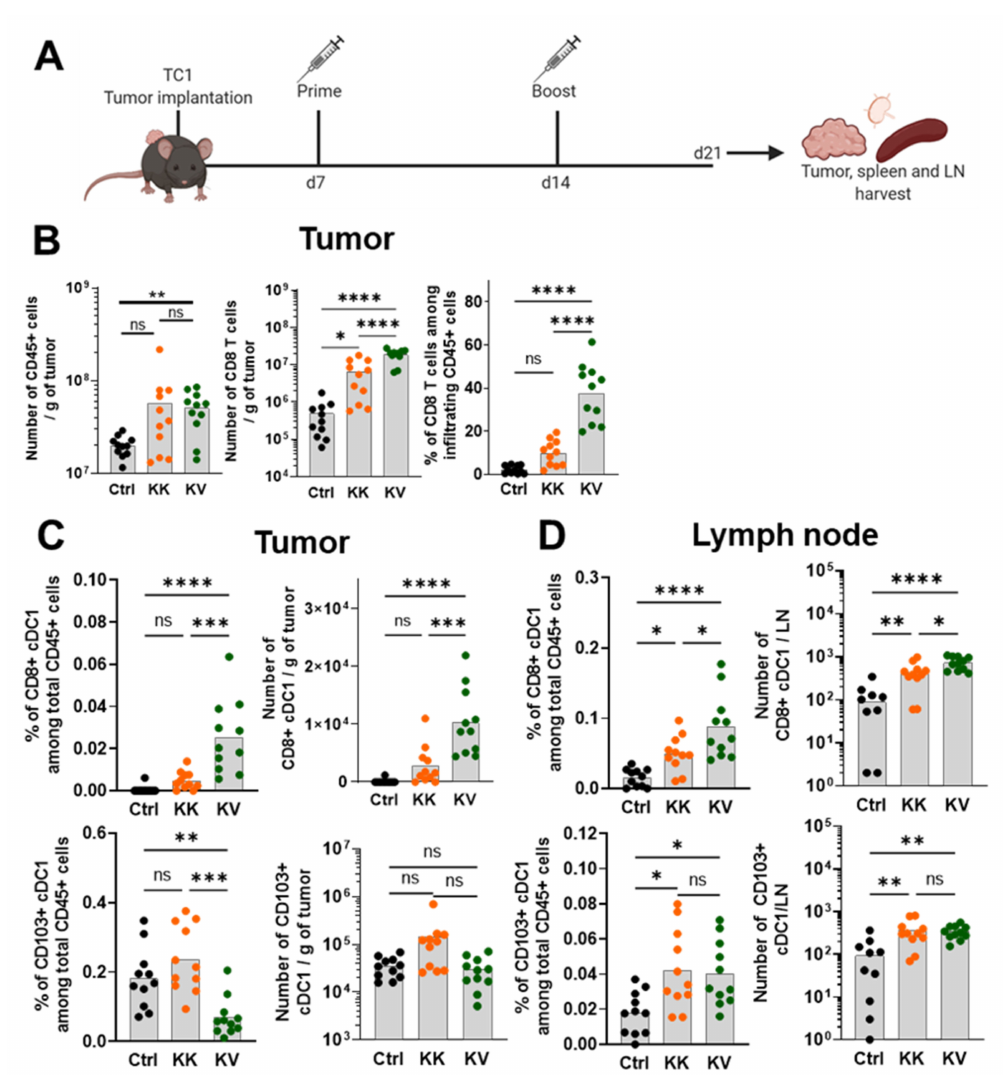
Figure S1D, moDCs were significantly higher in tumor-dLNs in KV-treated compared to KK and controls.